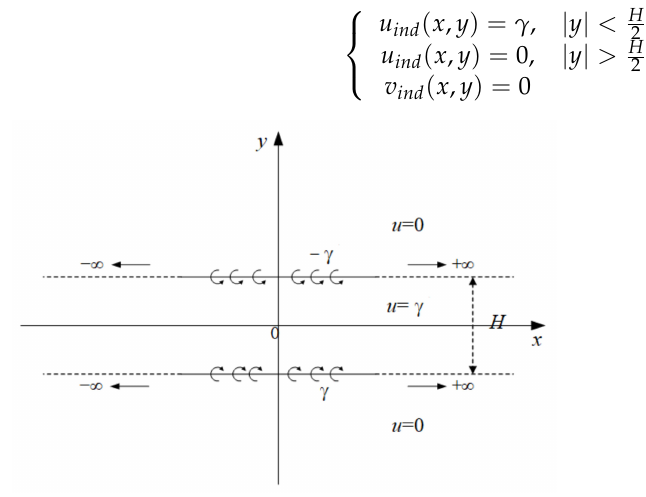
Figure 2. Infinite vortex sheets with opposite